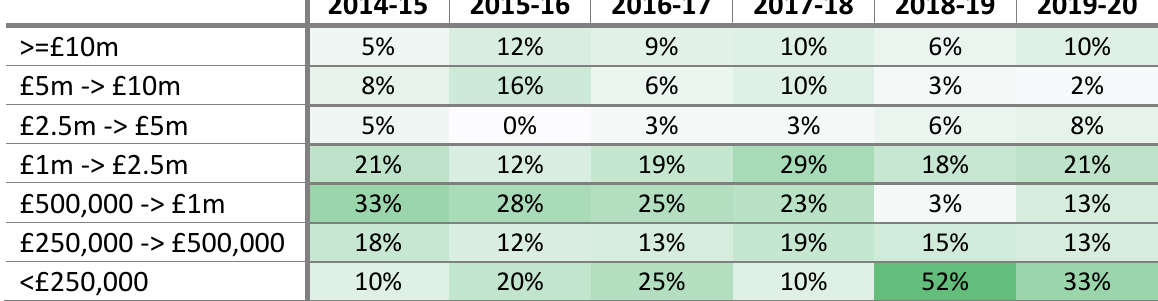
Table 11: Distribution of turnover from 2015 to 2020. UK